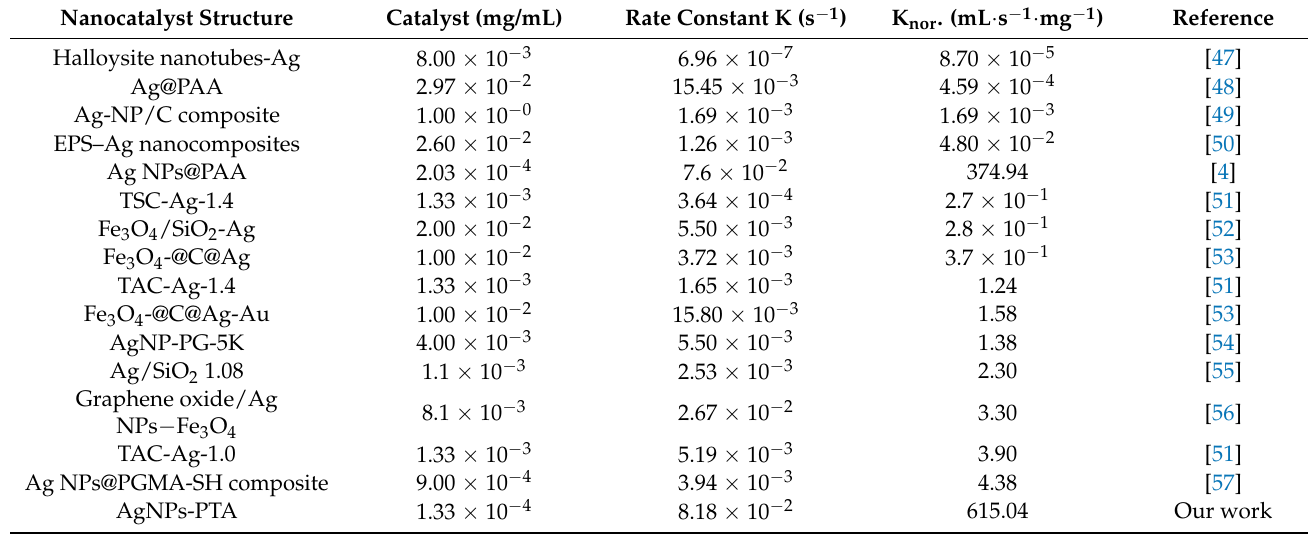
Table 2. Catalytic activities of Ag NPs-PTA nanocomposites for the 4-NP reduction in comparison with previously reported silver-based